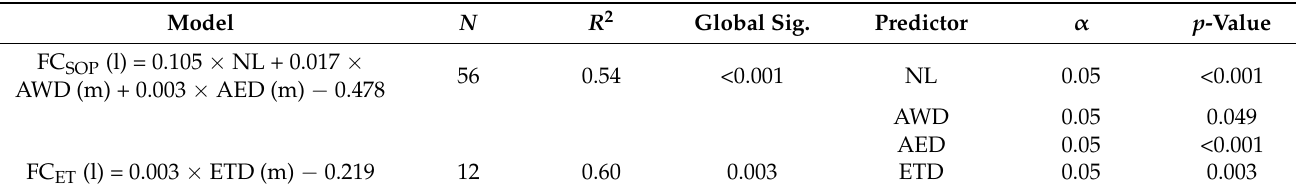
AWD = 8 m, AED = 103 m, minimum conditions), 0.820 (NL = 4.96, AWD = 14.43 m, AED = 177.30 m, average conditions) and 1.986 L (NL = 8, AWD = 26 m, AED = 394 m, maximum conditions),